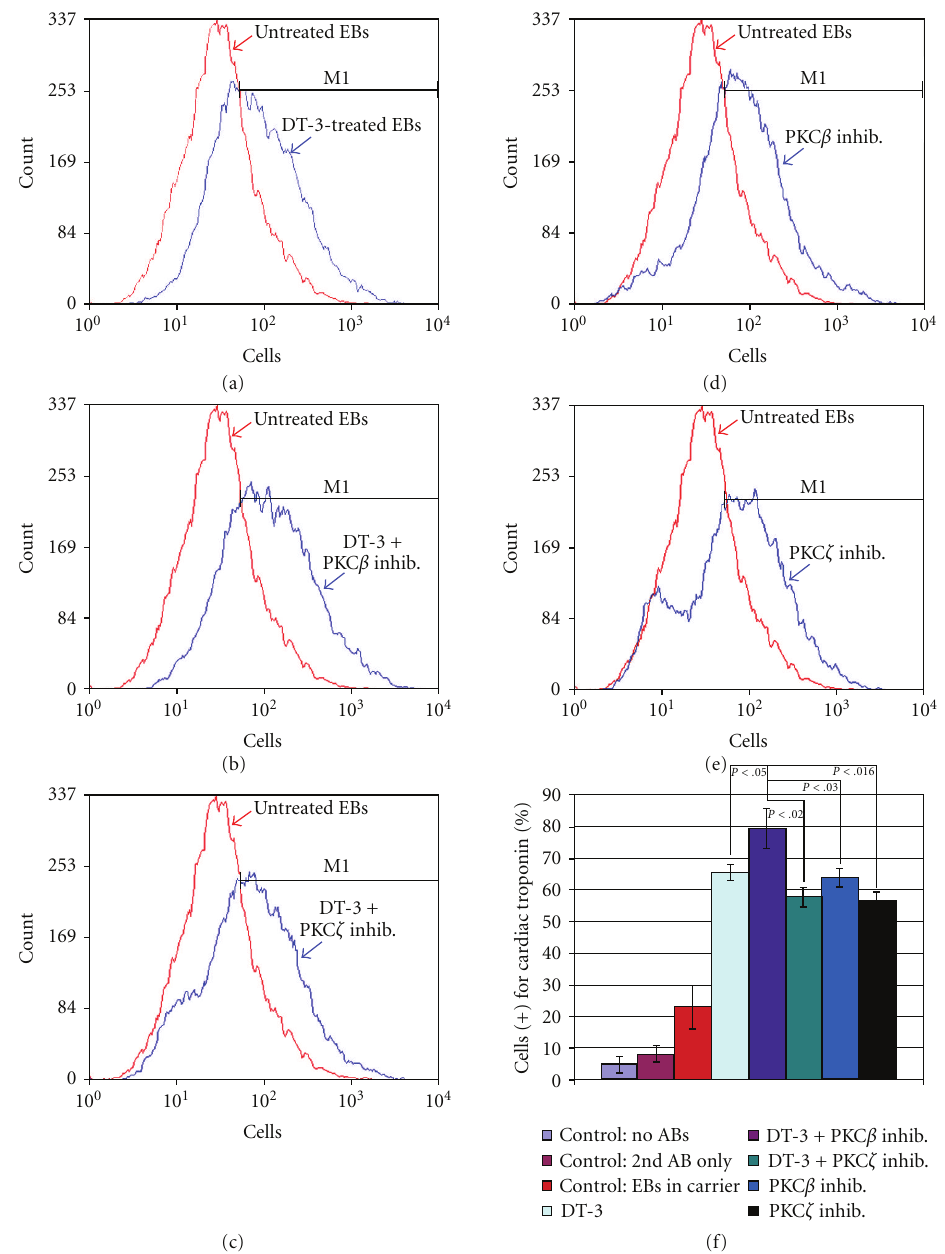
Figure 4: FACS analysis was used to quantify the percentage of cardiomyocytes di ff erentiated from ES cells using a conventional protocol (control: DMSO carrier + no drugs [5, 6, 17]) and using PKG and/or PKC isotypic inhibitors. (a)–(e) Representative raw FACS data. The x axis is the fluorescence level of cardiac troponin. The y axis is the cell count. M1 marks cardiac troponin (+) cells. (a) Inhibiting PKG alone (blue line) markedly pushed more cells towards the cardiomyocyte lineage when compared to control EBs di ff erentiated down the cardiomyocte pathway (red line). (b)-(c) However, combining PKG and PKC inhibitors skewed ES cell di ff erentiation further towards the cardiomyocyte lineage when compared to DT-3-treated EBs (a) and control EBs with the highest number of cardiac troponin-positive cells found in EBs treated with DT-3 and PKCbeta specific inhibitor (b). (d)-(e) PKC inhibitors alone also increased the number of cardiomyocytes generated from ES cells but not to the extent of dual inhibition of PKCbeta and PKG. (f) Proportions of cardiac troponin expressing cells from four experiments were analyzed using the two-sample test for binomial proportions. The proportion of CCE cells expressing cardiac troponin was significantly highest in PKG/PKCbeta-(purple bar) inhibited cells when compared to EBs di ff erentiated without drugs (red bar; P < . 001). Inhibiting both PKC β and PKG resulted in the most significant increase in cardiomyocytes when compared to all other treatments ( P values are shown for each comparison). Two types of controls were used for FACS analyses: (1) FACS machine parameters were set by analyzing cells from di ff erentiated EBs not subjected to any antibodies and cells from di ff erentiated EBs subjected to only secondary antibodies, and (2) cells from treated EBs were compared to cells from untreated (or DMSO carrier) EBs subjected to primary (anticardiac troponin) and secondary antibodies. EBs di ff erentiated without drugs (i.e., untreated) or without drugs but in DMSO carrier demonstrated virtually identical proportions of di ff erentiated cardiomyocytes (data not